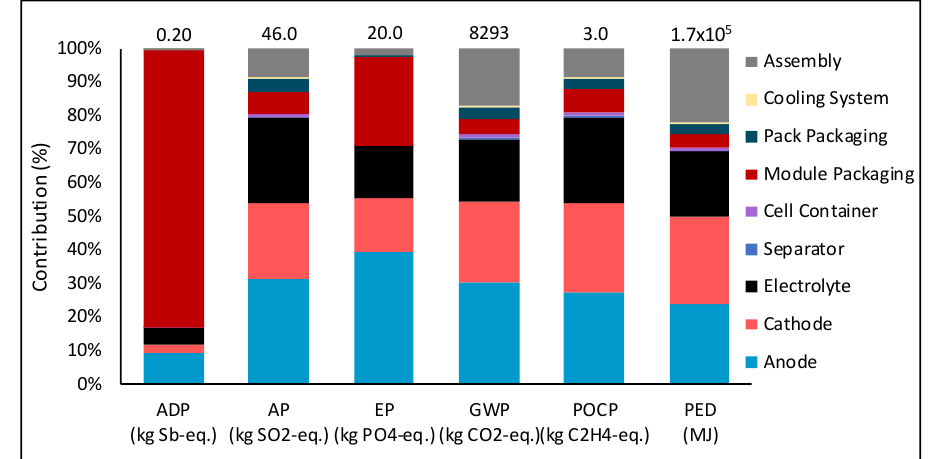
Figure 9. Percent contribution of each component to each impact category for the production of the Li-S battery. The numbers at the top of the stacked columns indicate the total value.